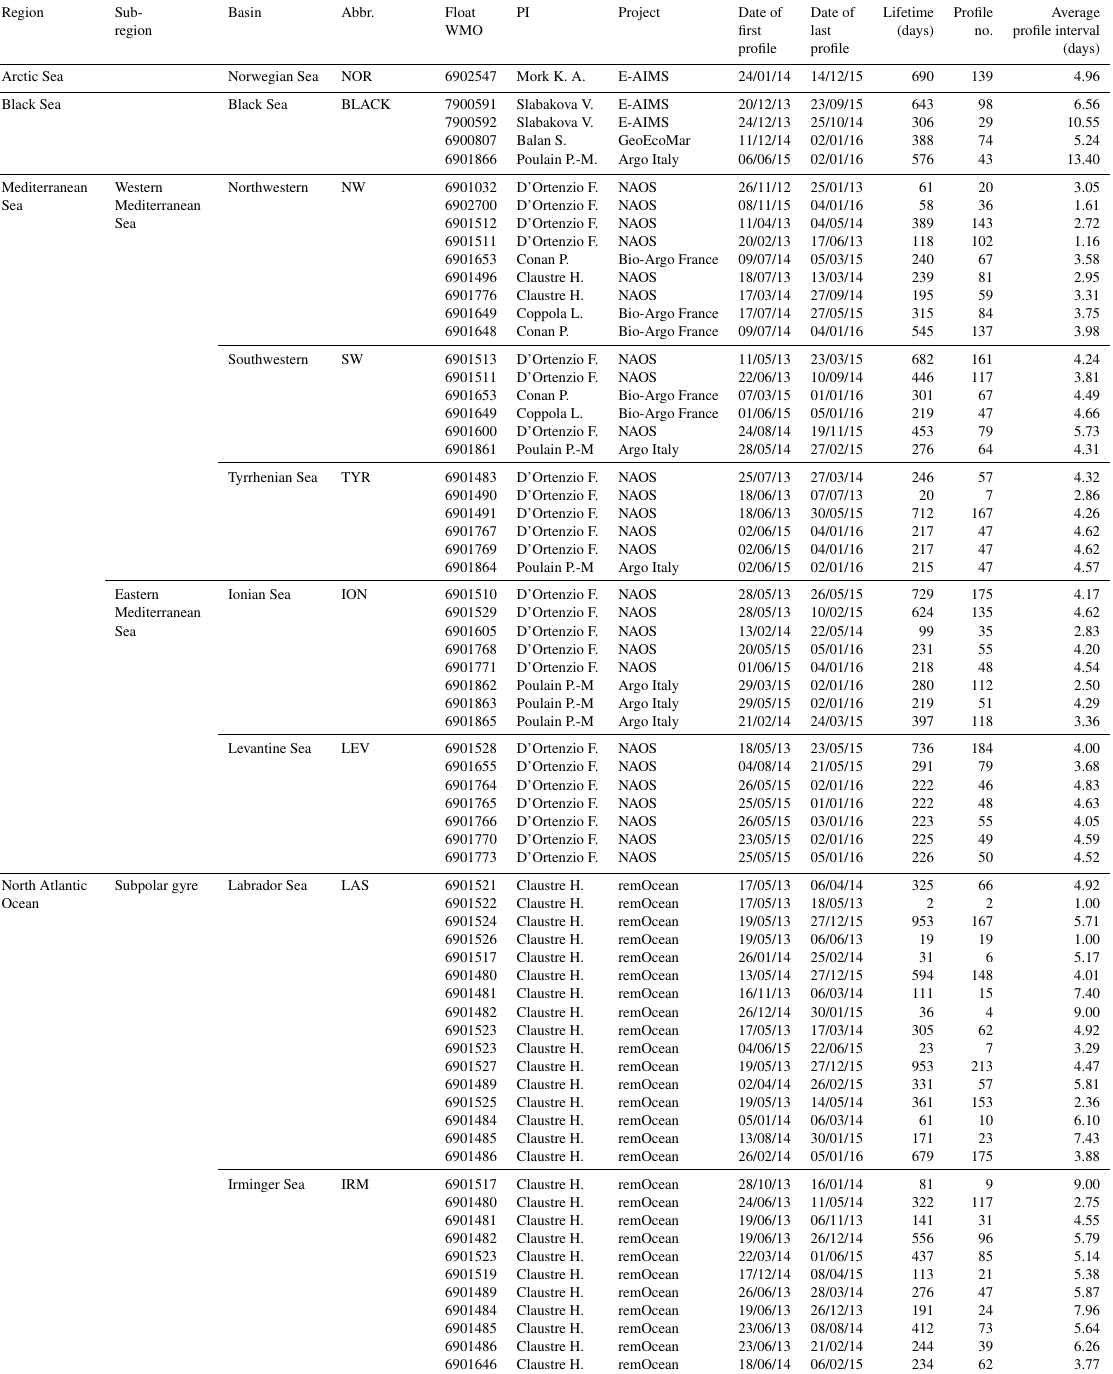
Table A1. Region, basin, abbreviation, and a list of the BGC-Argo floats for the 25 geographic regions included in the Biogeochemical-Argo database. Lifetime and average profile interval for each float is shown. Research project and principal investigator are also reported for each float. Note that the total number of floats is > 105 because some floats moved across two or more basins during their lifetime. An average profile interval of > 10 days indicates a temporary loss of communication between the server and the profiling float, which resulted in periods of inactivity. Dates in the table are given as